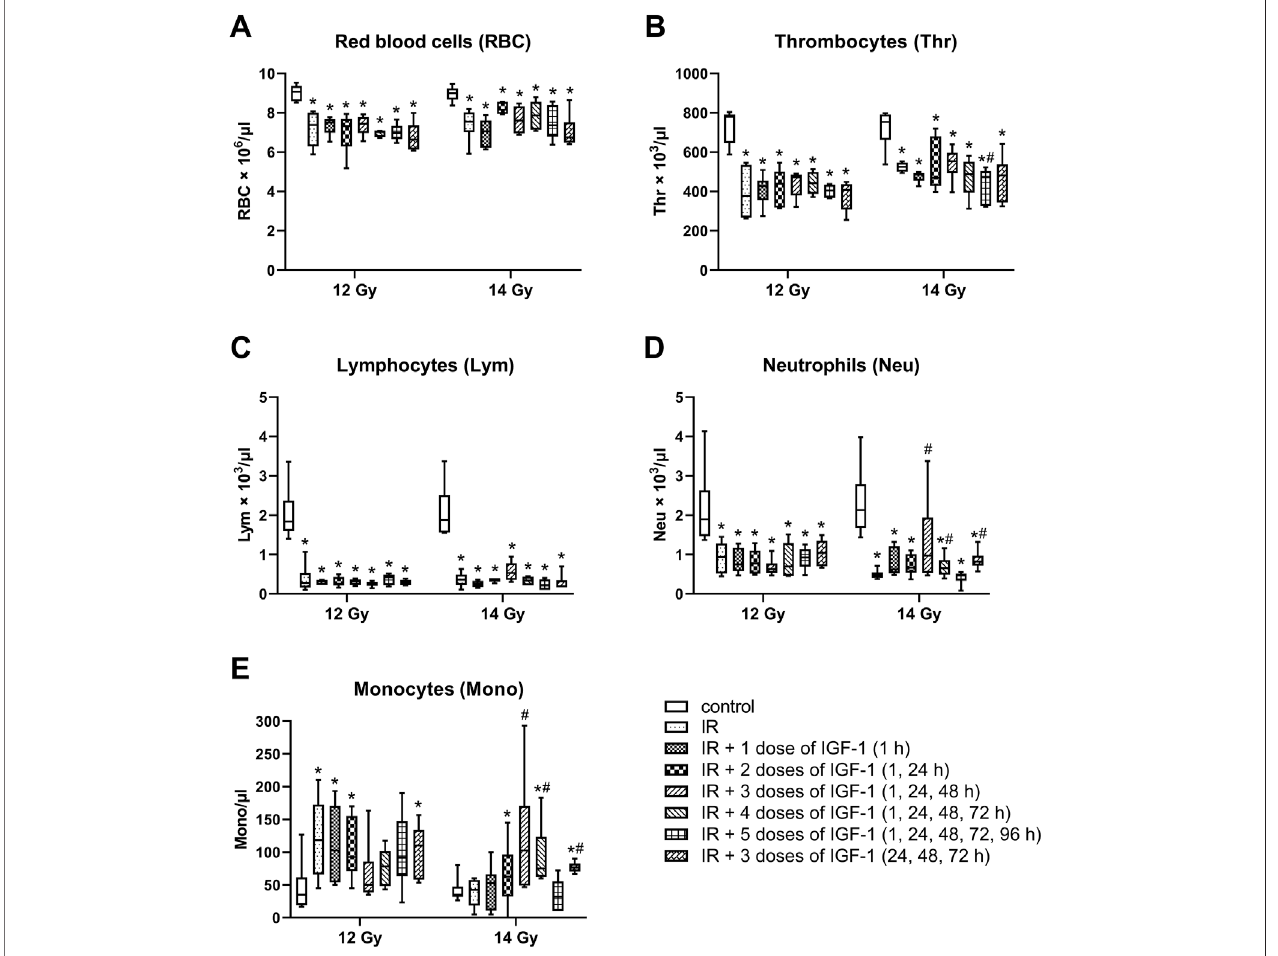
FIGURE8| EffectofdifferentIGF-1(1 mg/kg)therapeutical regimensonbloodhematologicalparametersofmiceirradiatedby12or14 Gywithshieldedheadand neck. (A) redbloodcells. (B) thrombocytes. (C) lymphocytes. (D) neutrophils. (E) monocytes.Signi fi cantlydifferentwhencompared withthenon-irradiatedcontrol:* p ≤ 0.05. Signi fi cantly different when compared with the solely irradiated group receiving no treatment: # p ≤ 0.05.